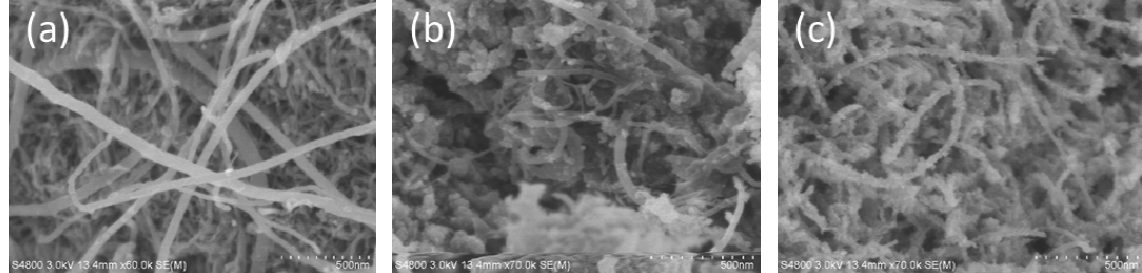
Figure 3. SEM images of the ( a ) MWCNTs and NiFe 2 O 4 /MWCNTs synthesized at ( b ) 150 °C and ( c ) 200 °C, respectively.